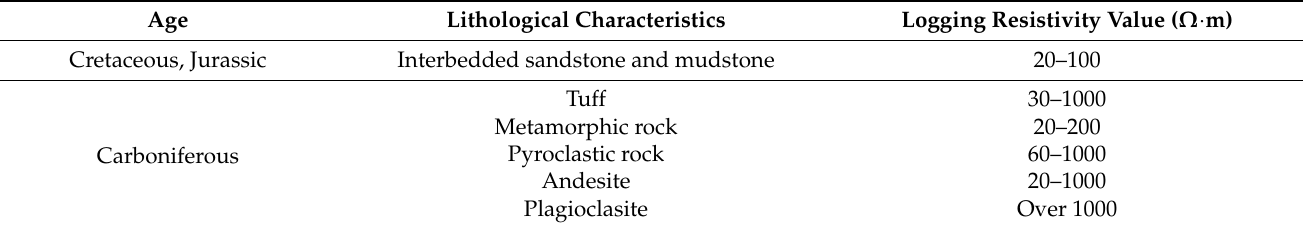
Table 1. Lithological and resistivity characteristic calibration